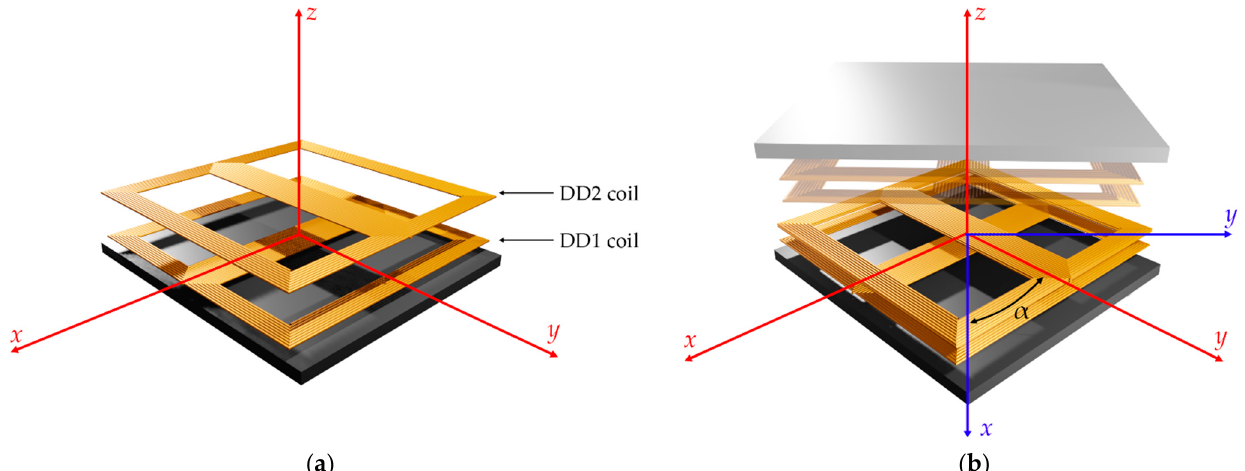
Figure 1. Double DD coils: ( a ) exploded view of the transmitter/receiver, ( b ) rotation between transmitter and receiver.